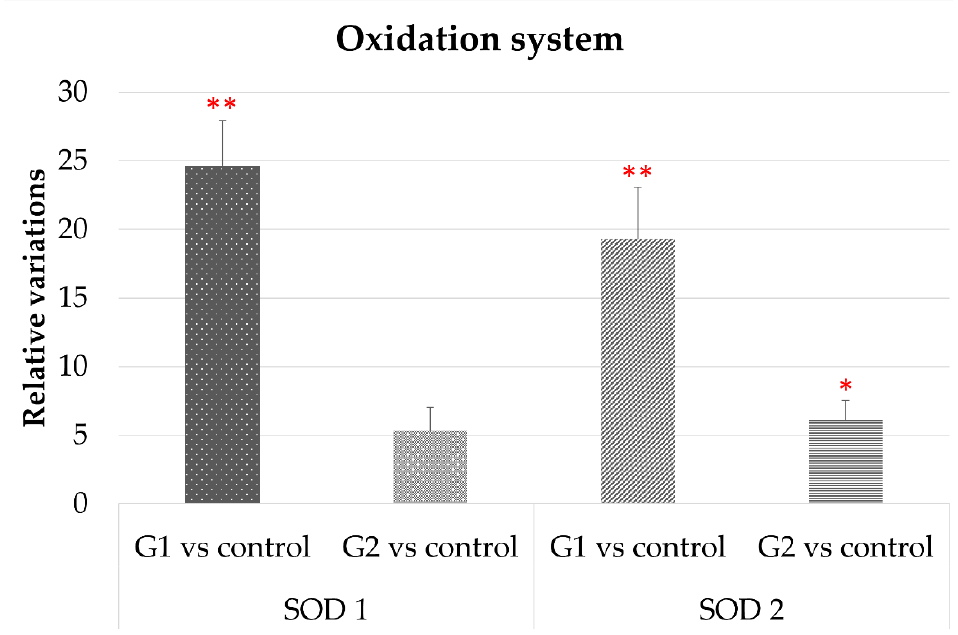
Figure 6. Variation in the expression of SOD1 and SOD2 in both experimental vs. control groups. * p < 0.05; ** p < 0.01.